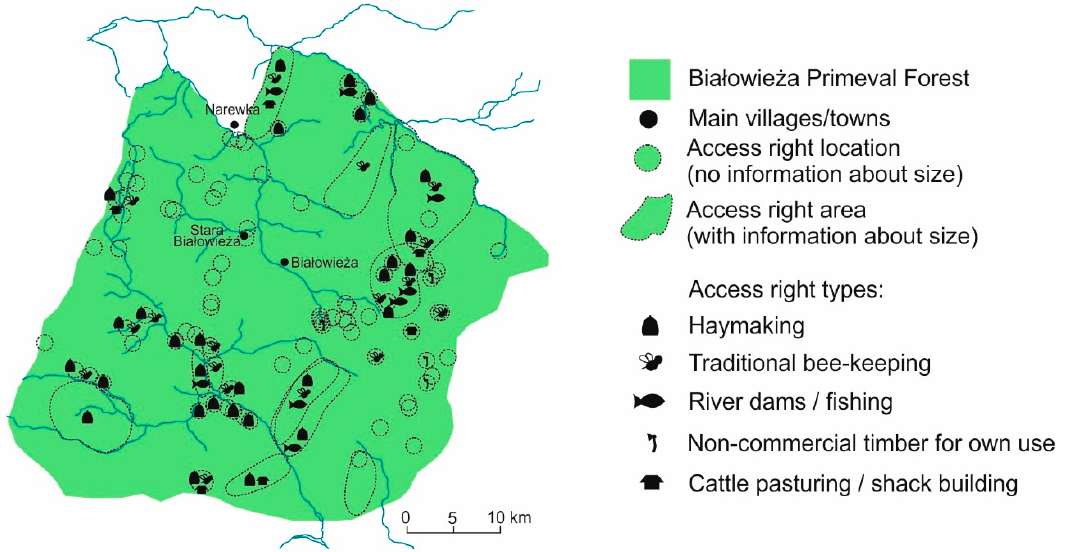
Figure 4. Distribution of access areas in BF in the 15th–17th centuries based on historical sources (access areas of unknown size marked by a standard circle), with type of allowed utilization marked (only cases with known type of activity).